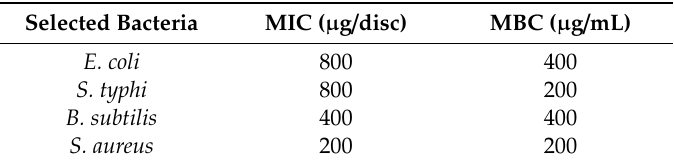
Table 3. Minimum inhibitory concentration (MIC) and minimum bactericidal concentration (MBC) of the synthesized compound for various bacteria.